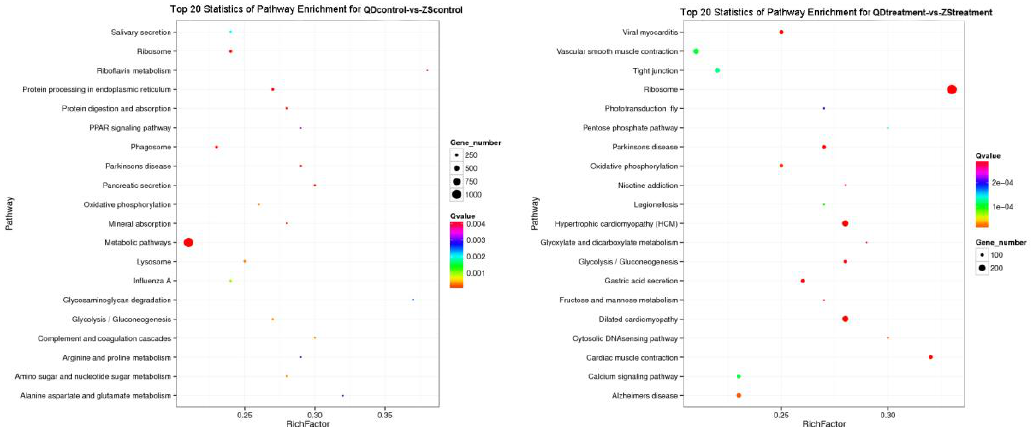
Figure 5. Top 20 pathway enrichment statistics for the two populations at different temperatures (ZS control : Zhoushan population at 20 °C; ZS treatment : Zhoushan population at 28 °C; QD control : Qingdao population at 20 °C; QD treatment : Qingdao population at 28 °C).